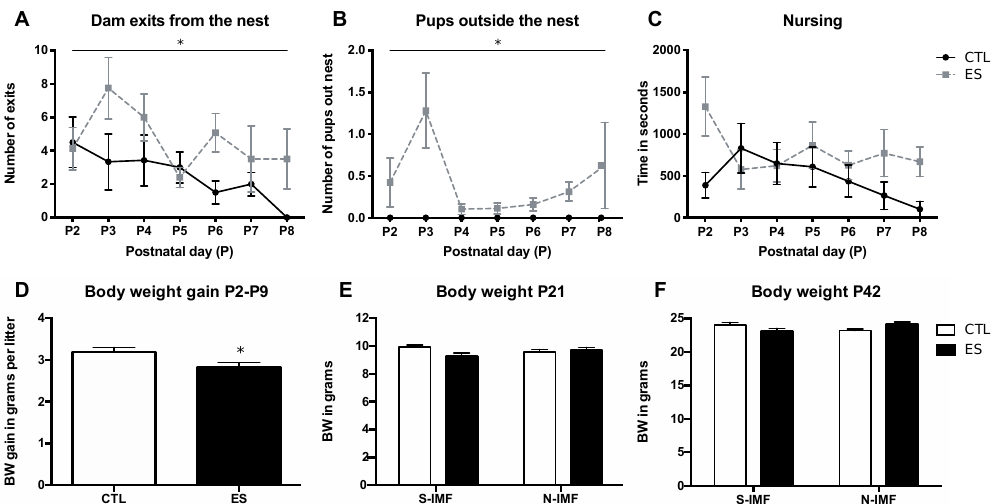
Figure 2. Limited nesting material results in fragmented maternal care and decreased body weight (BW) gain in pups between P2 and P9. ES dams exit the nest more often than CTL dams ( A ) and